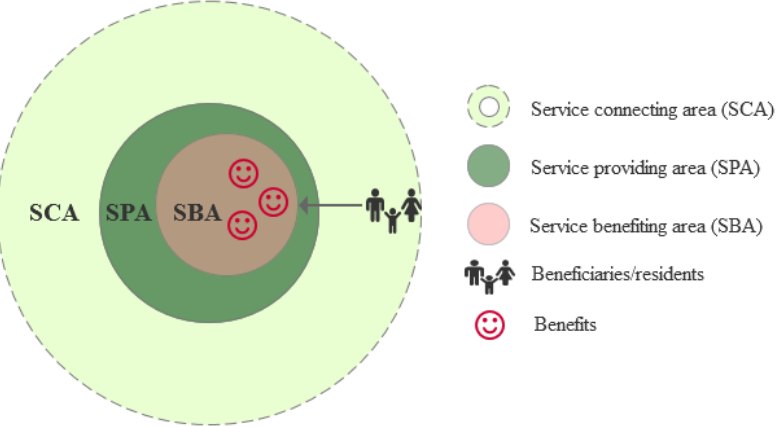
Figure 1. Spatial relationship between the recreational service providing area (SPA) and service benefiting area (SBA) (own draft based on Syrbe (2012), Syrbe (2017)) [17,19]). Recreational services in urban parks are user movement-related ecosystem services, where SBA is equal or similar to SPA because people must be in the SPA to benefit from the recreational services. The light green area is the service connecting area (SCA), such as the surrounding area of the urban park and nearby roads, which connects beneficiaries (people in residential or office areas) to the SPA.